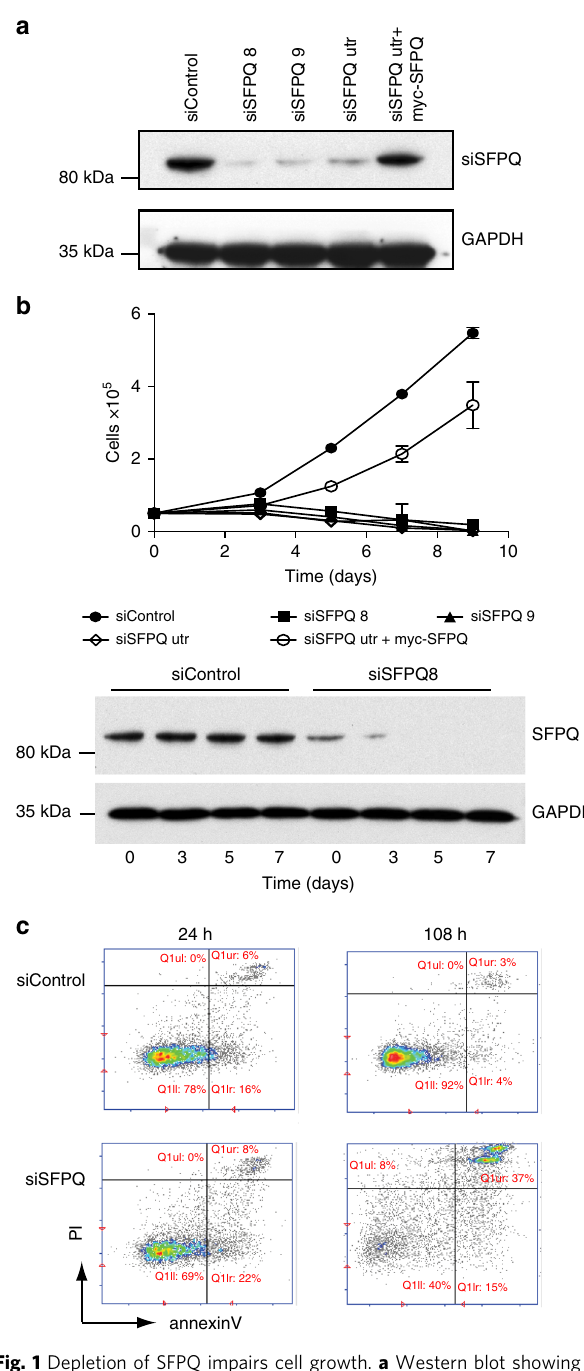
Fig. 1 Depletion of SFPQ impairs cell growth. a Western blot showing knockdown of SFPQ using different siRNAs. Expression of myc-SFPQ is resistant to knockdown by siSFPQutr. b Cell proliferation in U2OS cells transfected with different siRNAs targeting SFPQ and a non-speci fi c sequence (siControl). Cell number was measured 48 h after transfection with siRNA (time = 0) and then at time = 3, 5, 7, and 9 days. Overexpression of siRNA-resistant myc-SFPQ rescued cell growth in SFPQ knockdown cells. Data are an average n = 3 independent experiments ± s.d. Western blot (below) shows the level SFPQ protein over time.